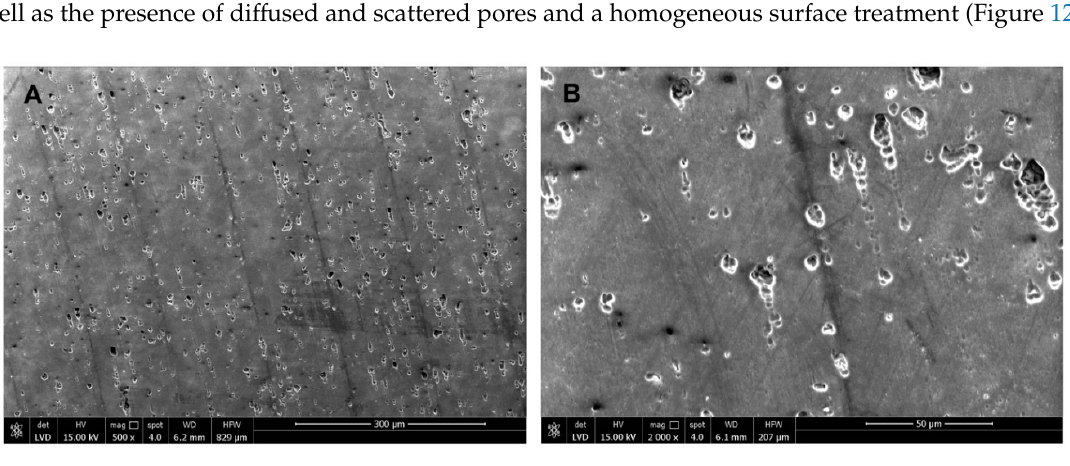
Figure 12. Environmental scanning microscopy morphological analysis on DURALTI ® -treated aluminum disks surface observed at ( A ) 300 μ m and ( B ) 50 μ m.